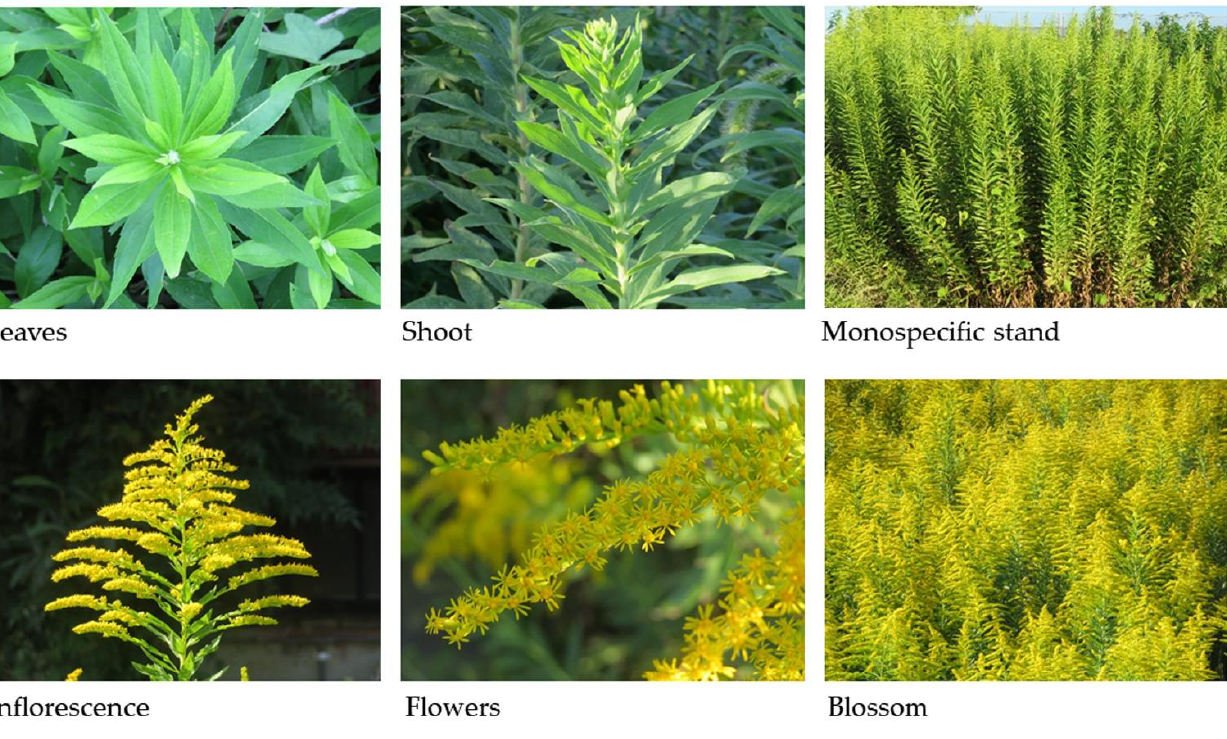
Figure 1. Solidago canadensis